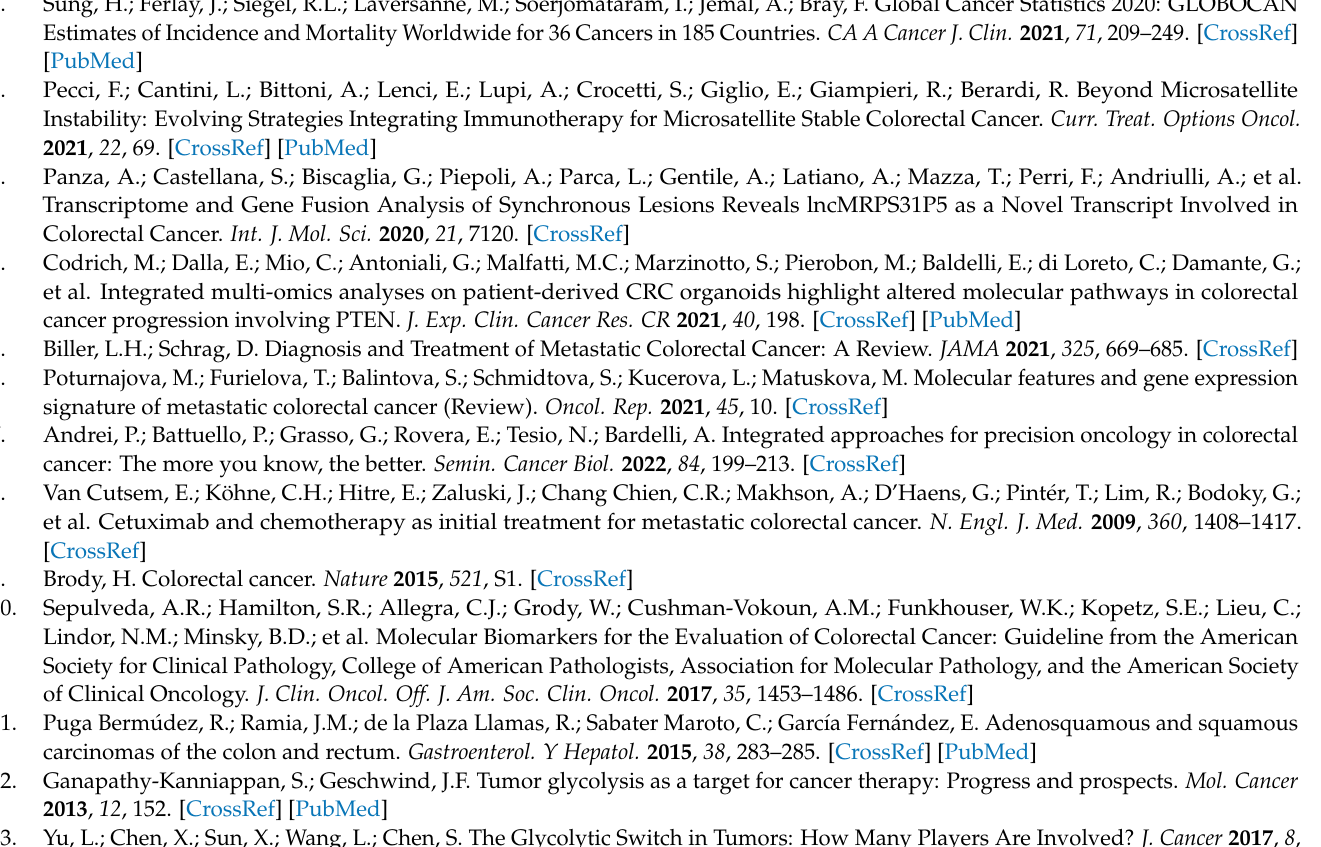
Table S2: Primer sequence of genes in